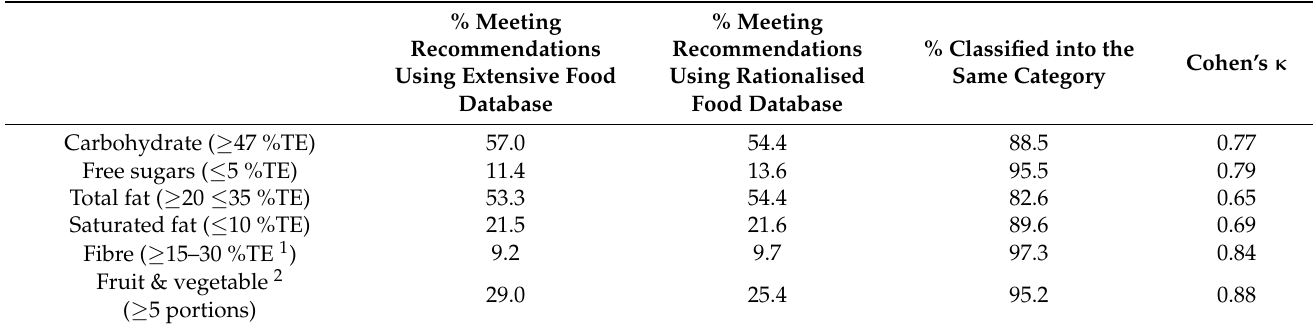
Table 4. Percentage of respondents meeting dietary reference values for selected nutrients [19–21], and fruit and vegetables [22] intake from food sources (excluding nutritional supplements) in